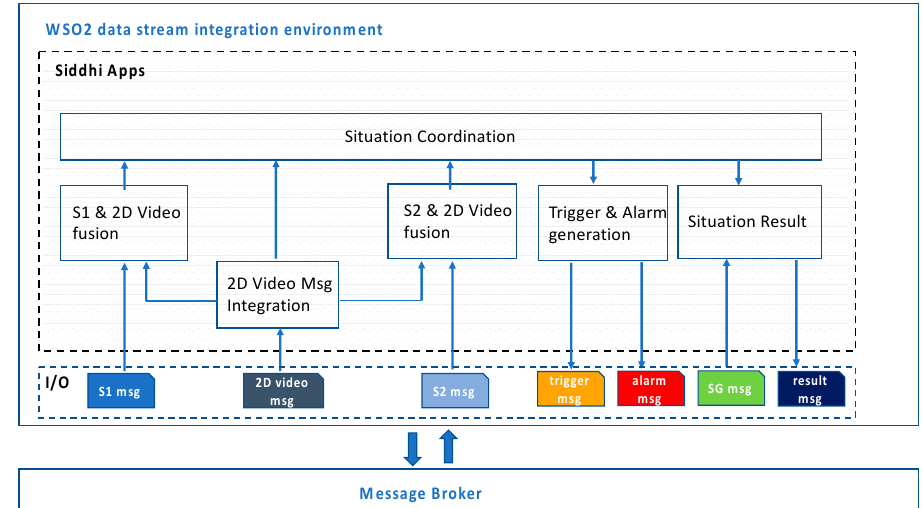
Figure 5. Data fusion Siddhi Apps.